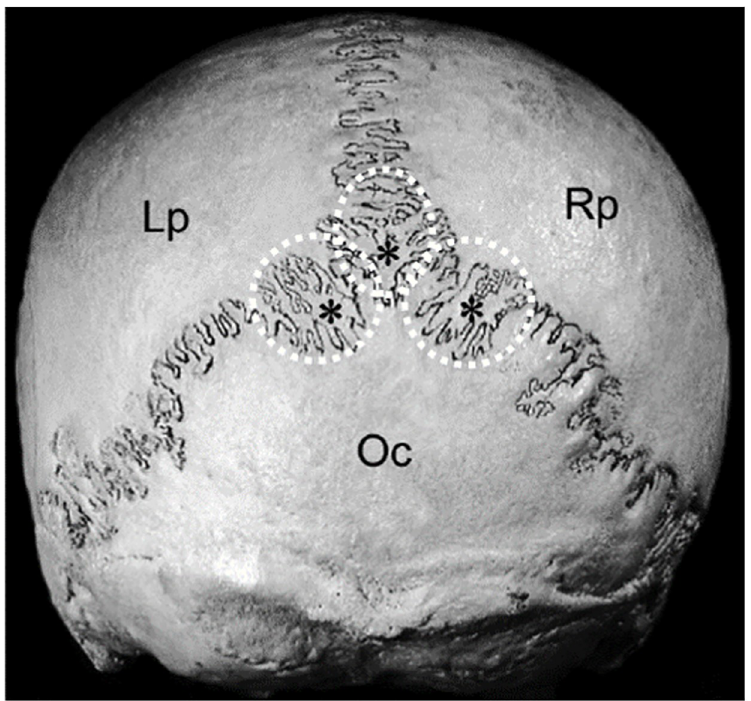
Fig 1. Illustration of Wormian (intrasutural) bones located in the lamboid suture in the human skull (indicated by asterisks and circled); caudal view of the skull. Lp: Left parietal bone; Rp: Right parietal bone; Oc: Occipital bone (modified from [6]). Used with